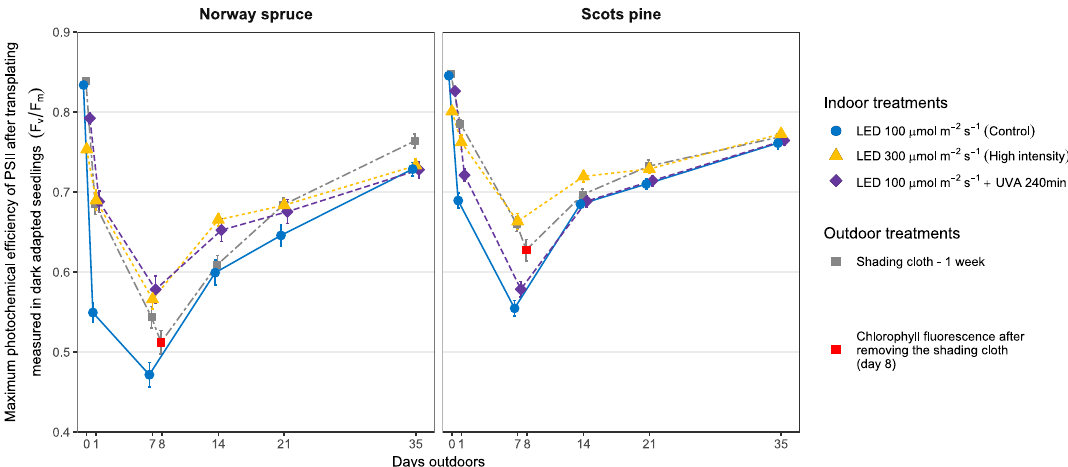
Figure 4. Chlorophyll fluorescence (F v / F m ) after transplanting outdoors for seedlings of Norway spruce and Scots pine cultivated indoors under LED lights. The same individual seedlings were repeatedly measured during the first 35 days of natural light exposure. An extra measurement was done only on the shading cloth treatment to measure the e ff ect of removing the cloth on the 8th day (red square). The data points represent the mean ( n = 15) for each treatment at that measuring time and the error bars represent the standard error of the sample mean.